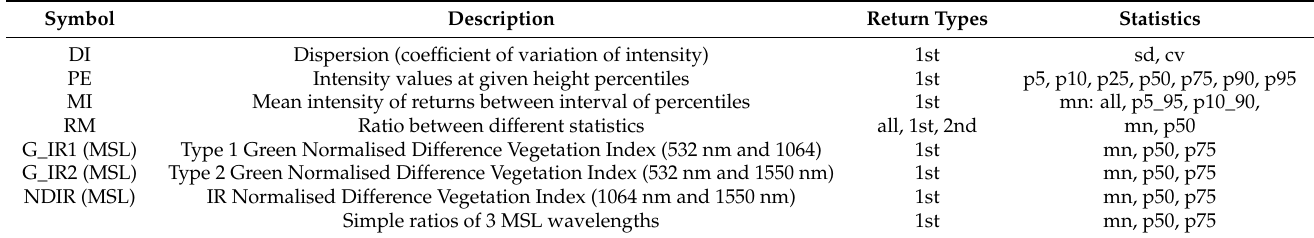
Table 3. Description of intensity-based features for each crown (prefix =